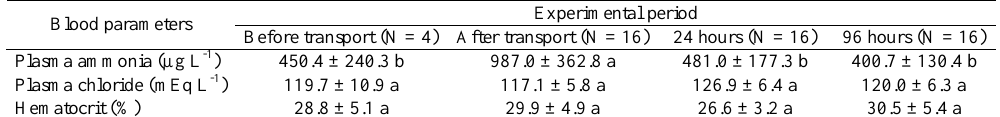
Table 2. Plasma ammonia, plasma chloride and hematocrit before and after transport simulation with jundiá juveniles in plastic bags at different loading densities (75, 150, 250 and 350 g L -1 ). Since there were no significant differences among treatments, lowercase letters in the rows show significant differences (P < 0.05) of means (composed by values of all treatments) among sample